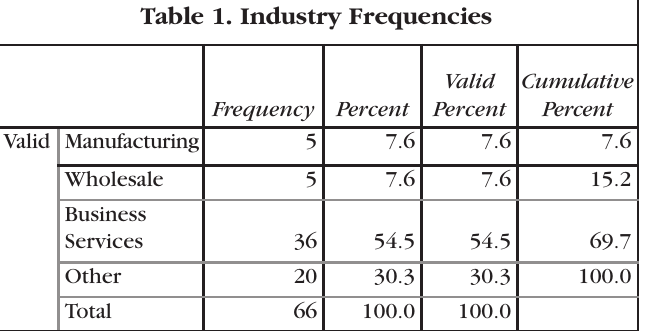
Table 1. Industry